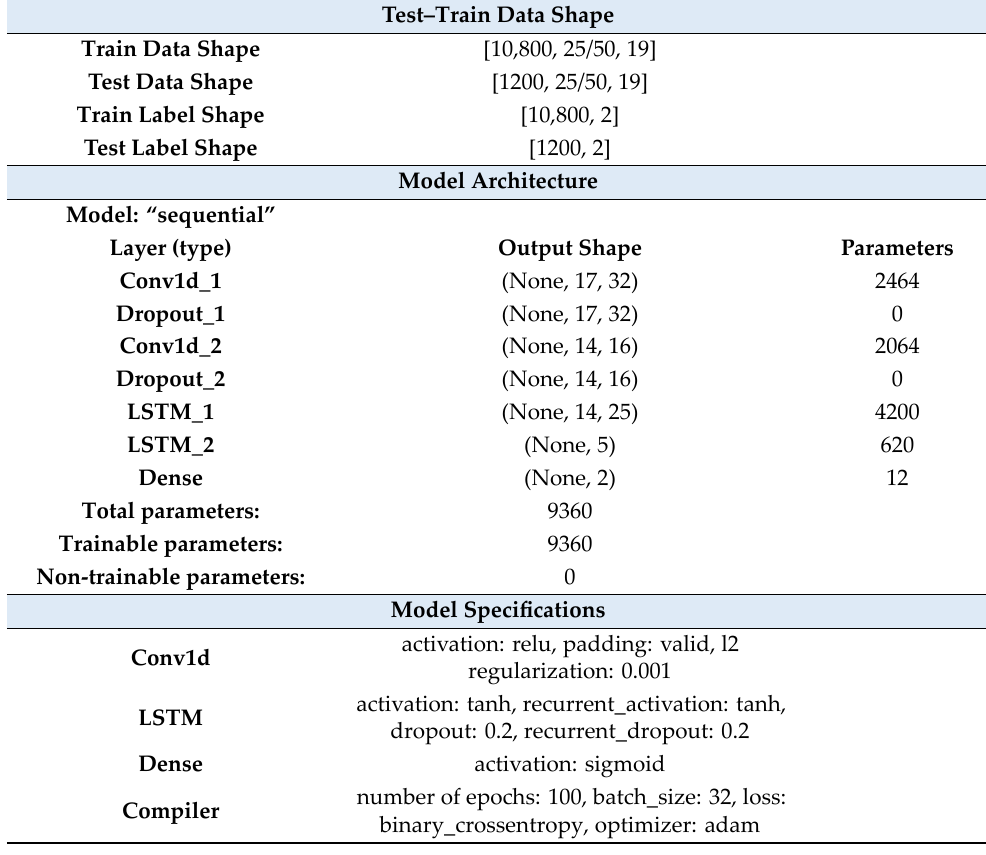
Table 4. Model summary for Phase 1, including two 1‑dimensional convolutional layers and two stacked LSTM layers, two Dropout layers and a final Dense layer. Terms are explained in the on‑ line Supplementary Materials. The Output Shape defines the size of the output matrix. ‘None’ is a placeholder for the size of the dataset so that it is not fixed but can be varied; the following numbers within parentheses indicate the batch size and time steps used. The number of parameters required for each layer is also